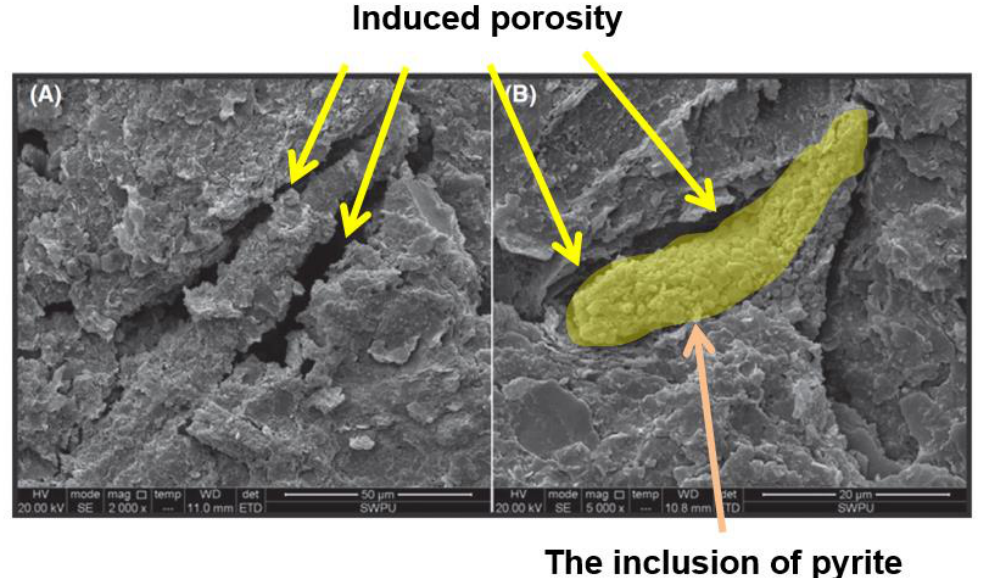
Figure 6. SEM images of the oil shale after microwave irradiation: ( A ) fracture generation after microwave heating; ( B ) morphology of pyrite after microwave heating [94].